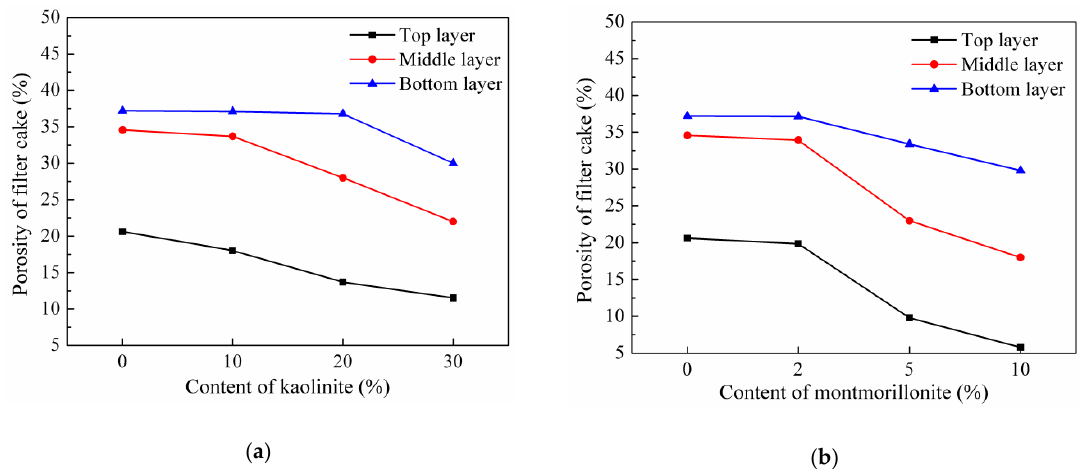
Figure 6. Porosity of the filter cake containing different contents of ( a ) kaolinite and ( b ) montmorillonite.